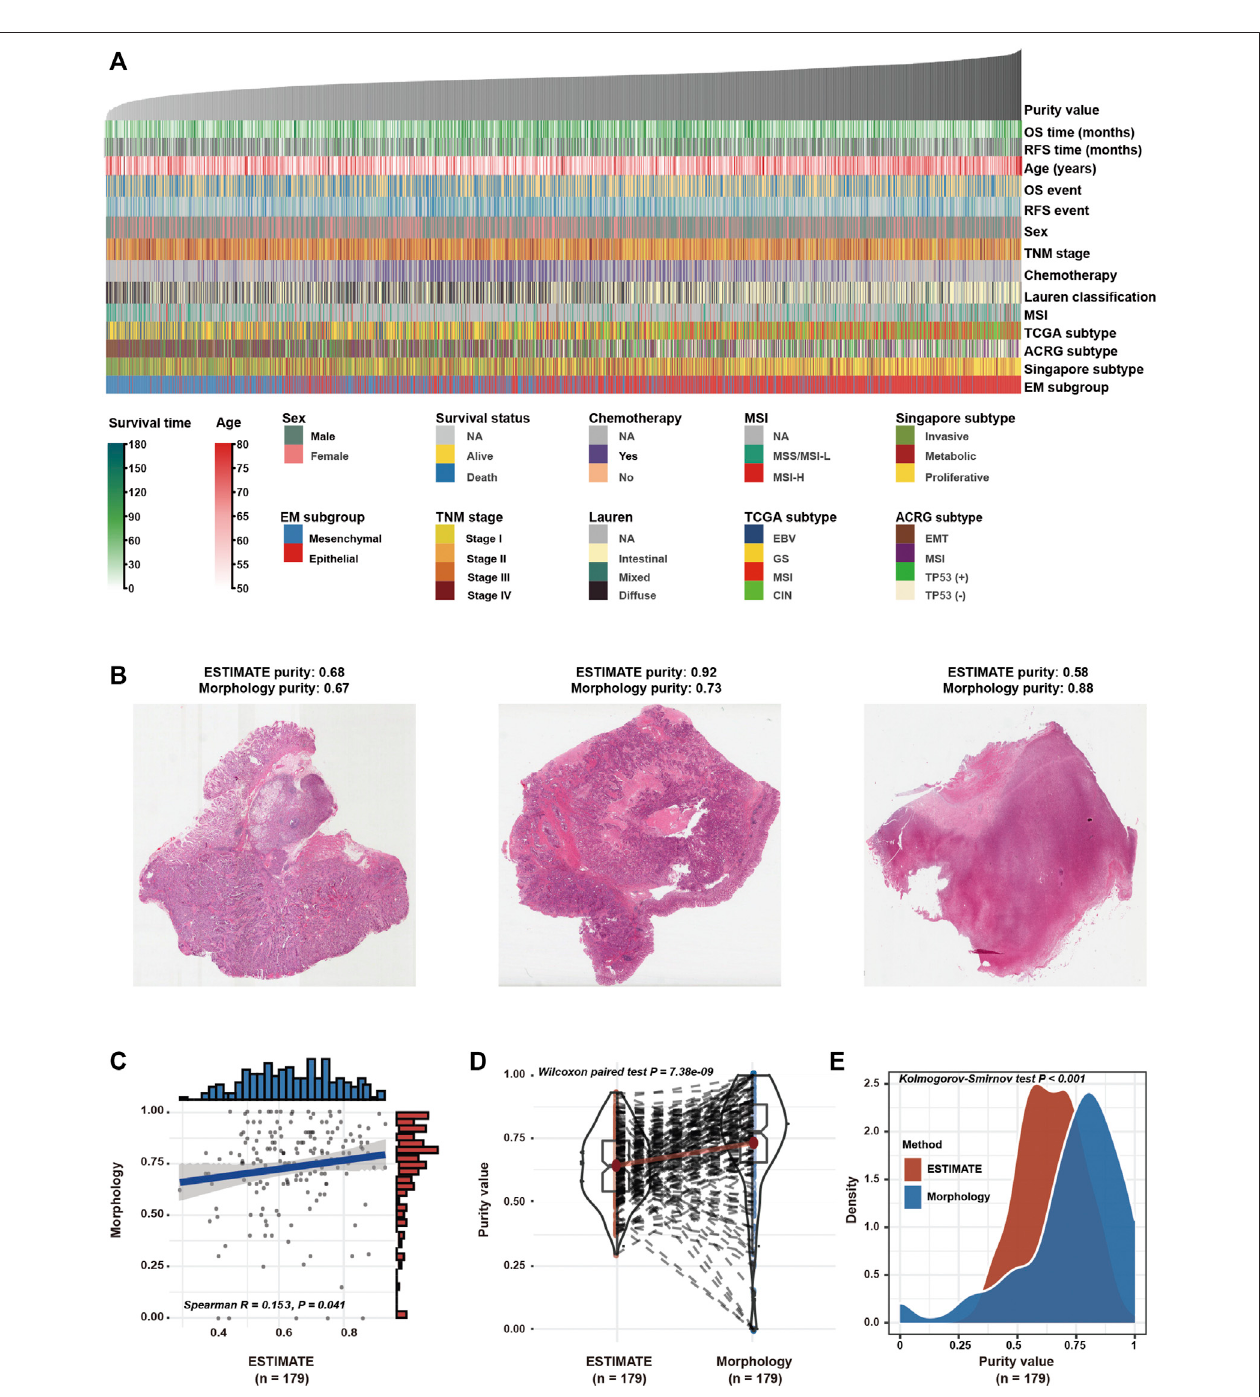
FIGURE1| Tumourpurityisanintrinsicpropertyofgastriccancer(GC). (A) ThelandscapeofclinicopathologicalandmolecularcharacteristicsassociatedwithGC purity. (B) Representative slides of GC tissues. (C) Spearman correlation analysis of GC purity based on morphological assessment and the ESTIMATE method. (D) Distributionof GCpurity evaluated based on morphologicalassessmentand the ESTIMATE method. The upper and lower ends ofthe boxesrepresentthe inter-quartile range of values. The lines in the boxes represent the median value. The whisker edges are the last data points within 1.5 of the inter-quartile range. The horizontal width of the violin represents the data density. (E) Density distribution of GC purity estimated based on morphological assessment and the ESTIMATE method.